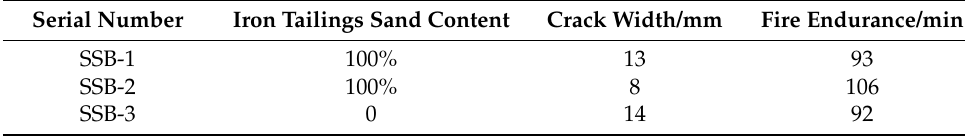
Figure 9. Crack, burst and damage of the simply supported beam under fire: ( a ) SSB-1; ( b ) SSB-2; ( c ) SSB-3. Table 3. Statistics of simply supported beam test results under fire.